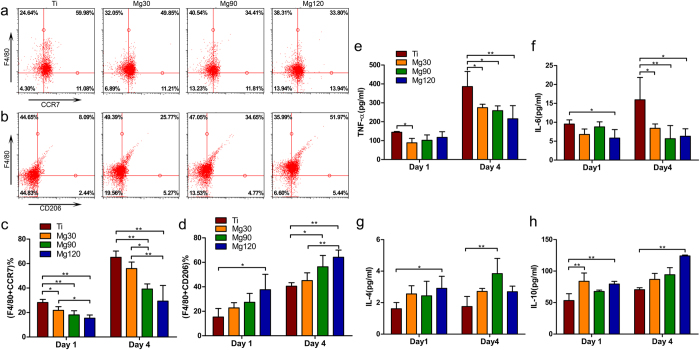
Expression of cell surface markers on RAW cells, as determined by flow cytometry; cytokines secreted by RAW cells on various surfaces, as determined by enzyme-linked immunosorbent assay (ELISA).Representative dot plots showing: (a) F4/80 and CCR7 double staining, (b) F4/80 and CD206 double staining, (c) Percentage of F4/80 and CCR7 double positive cells (M1), (d) Percentage of F4/80 and CD206 double positive cells (M2). Cytokine production: (e) TNF-α, (f) IL-6, (g) IL-4, (h) IL-10. (Statistically significant difference: *p < 0.05; **p < 0.01; triplicate). (F4/80: mouse epidermal growth factor-like module-containing mucin-like hormone receptor-like 1; CCR7: C-C motif chemokine receptor type 7).